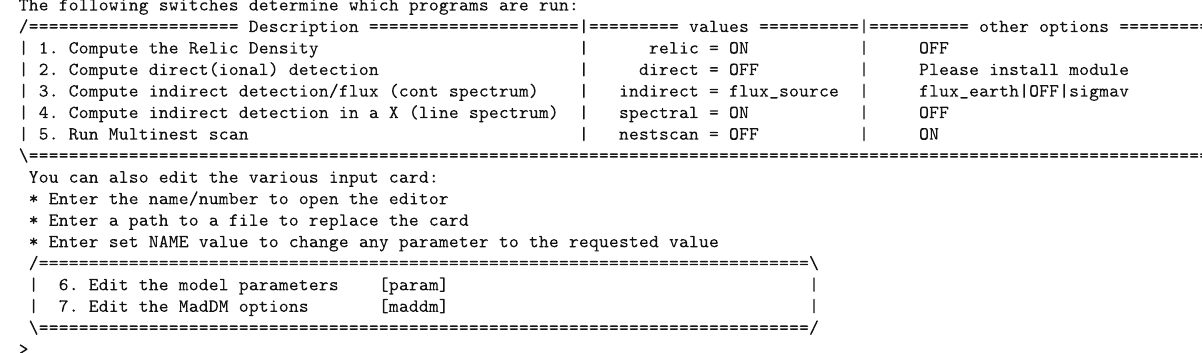
tion spectral feature calculations are turned on, while direct detection and the scan capability with MultiNest are switched off